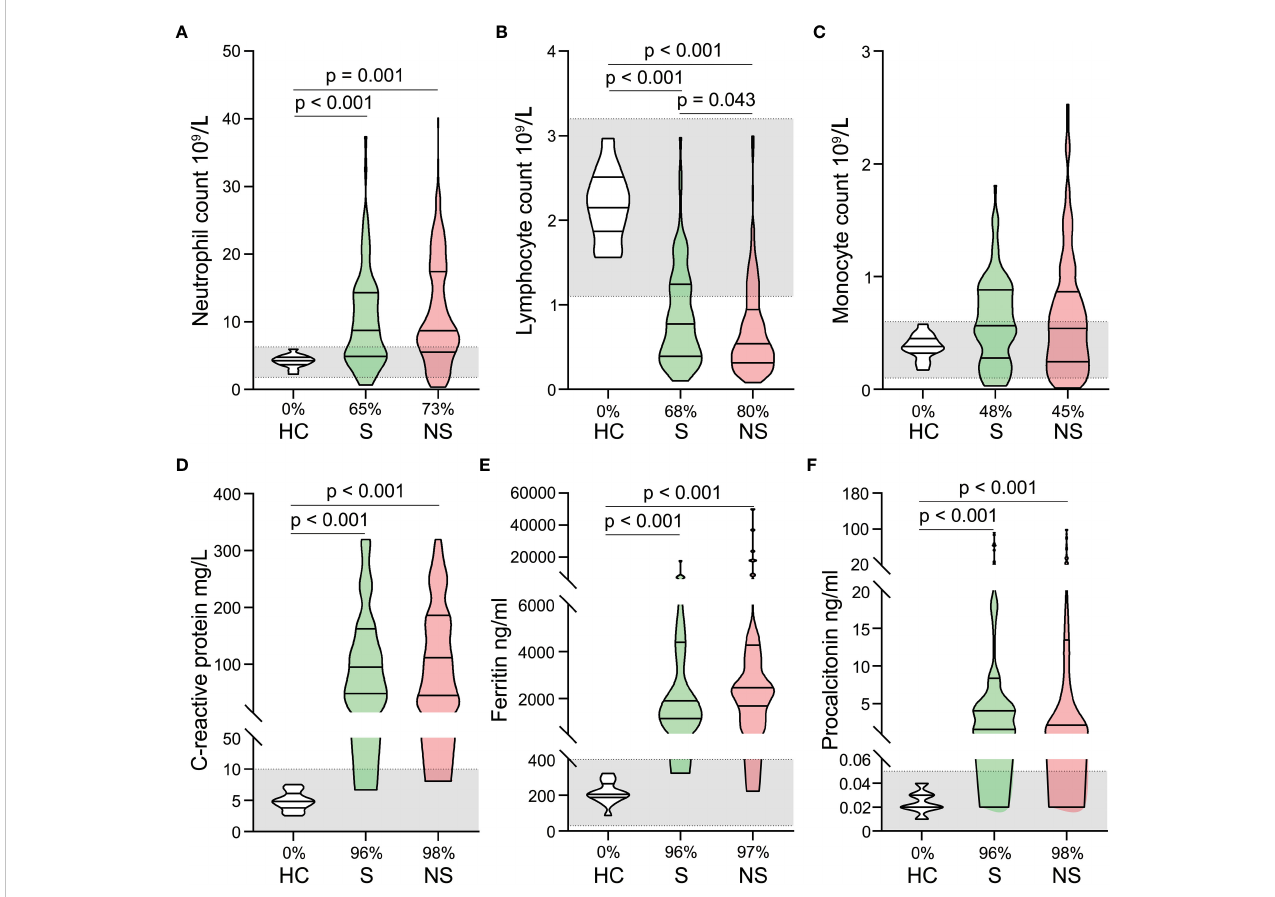
FIGURE 1 Alterations in blood routine and infection biomarkers in patients with septic shock. Neutrophil counts (A) , lymphocyte counts (B) , monocyte counts (C) , C-reactive protein levels (D) , ferritin levels (E) , and procalcitonin levels (F) were compared among healthy controls, survivors, and nonsurvivors. The shaded region represents the normal value range. The proportions of patients whose test results are above the upper limit of the normal range ( A, C – F ) or below the lower limit of the normal range (B) are shown on the